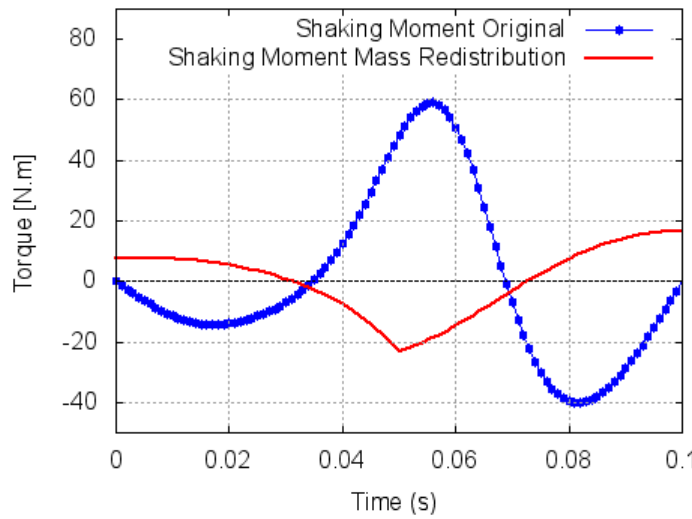
Figure 11. Shaking moment comparison: The blue curve is the shaking moment in the original manipulator. The red curve is the shaking moment when the mass of the driving links are redistributed and the tool is guided with a “bang-bang”